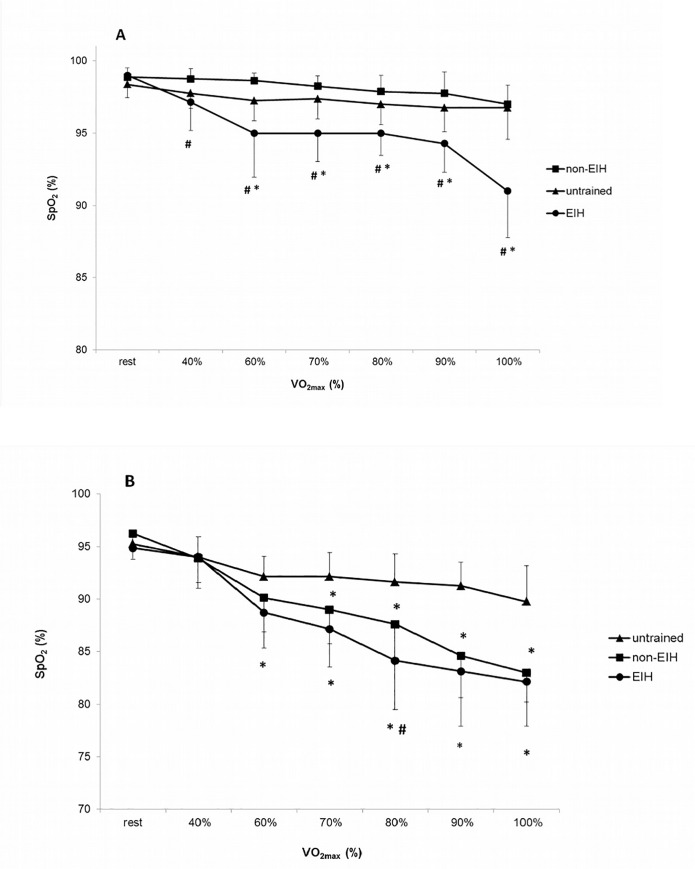
Kinetics of haemoglobin O2 saturation (SpO2) during rest and incremental maximal exercise at sea level (A) and altitude (B). * Significantly different from untrained (p < 0.05); # Significantly different from non-EIH (p < 0.05). Note that, at all intensities, SpO2 values at altitude are significantly different from sea level in the three groups (p < 0.05).